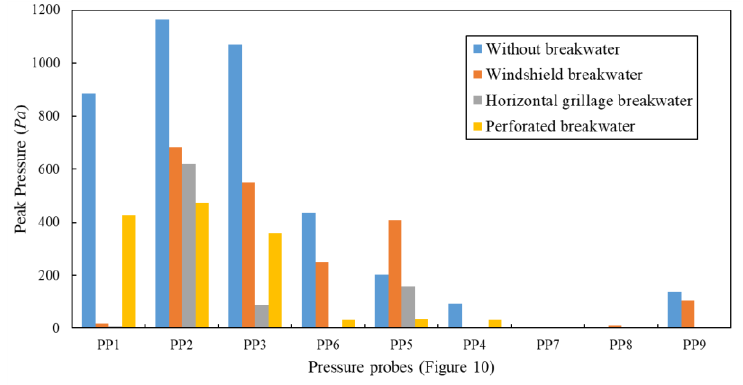
Figure 18. Comparison of peak pressure at all the pressure probes set on the vertical deck plate.